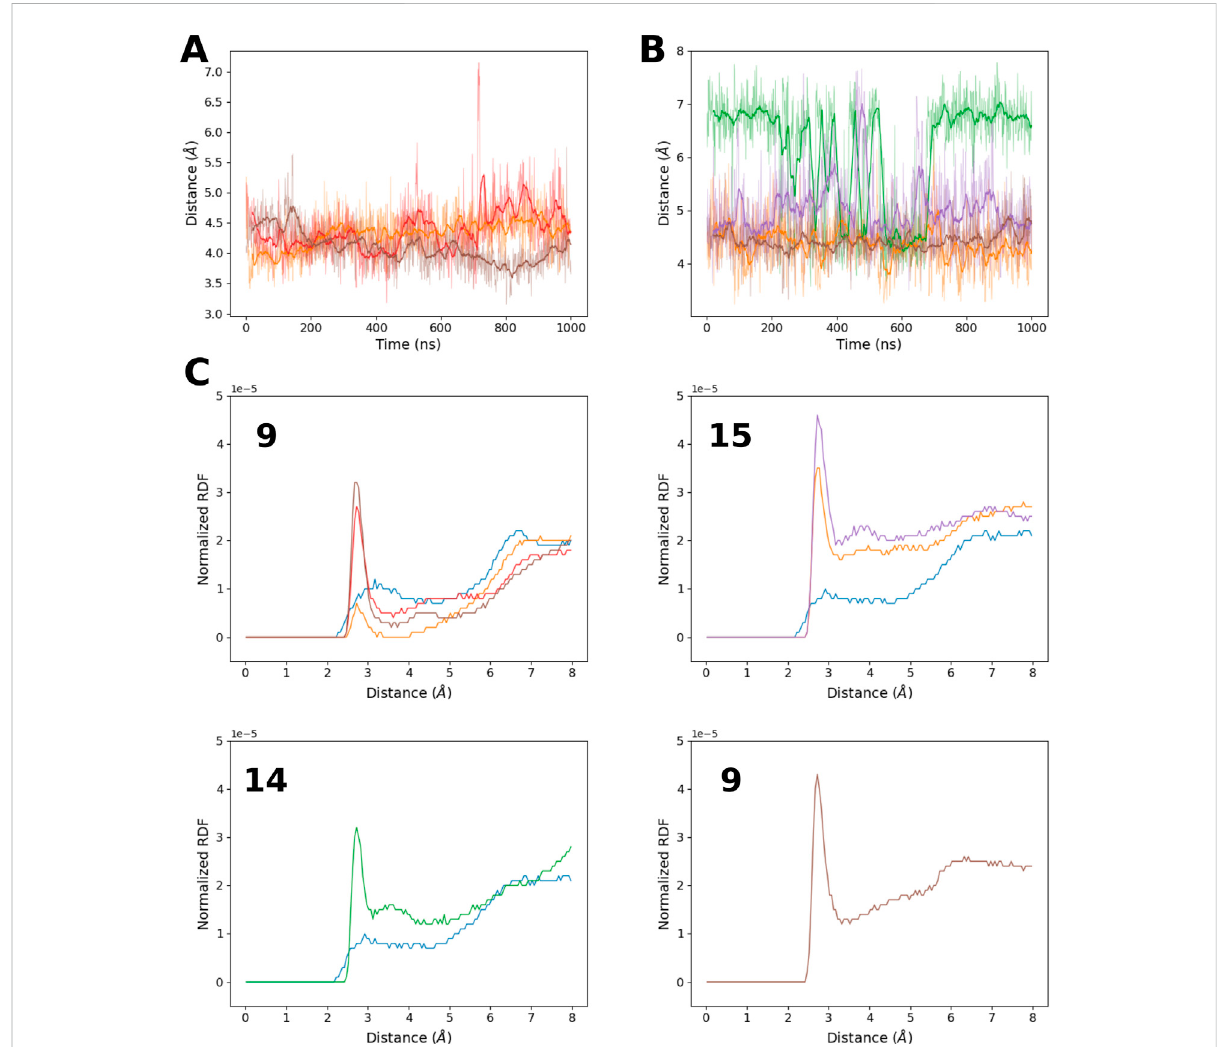
FIGURE 2 (A) Time evolution of the distance between 8-oxoG9 O8 and the closest 8-oxoG9 phosphate oxygen atom for the RNA sequences: ° GCCCUG ° G (orange), ° GCCCUGG (red), and ° GCCC ° GGG (brown). (B) Time evolution of the distance between 8-oxoG O8 and the closest 8-oxoG phosphate oxygen atom for damage at position 15 in the RNA sequences ° GCCCUG ° G (orange) and GCCCUG ° G (purple), at position 14 for the RNA sequence GCCCU ° GG (green), or at position 13 for ° GCCC ° GGG (brown). (C) Radial distribution function of the water oxygen atom around the O8 atom of different 8-oxoG lesions in position 9, 15, 14, or 13. If possible, the corresponding radial distribution function around the H8 atom of the undamaged guanine in the control simulation is also represented. Line colors correspond to the RNA sequences: control (blue), ° GCCCUG ° G (orange), GCCCU ° GG (green), ° GCCCUGG (red), GCCCUG ° G (violet), and ° GCCC ° GGG (brown).